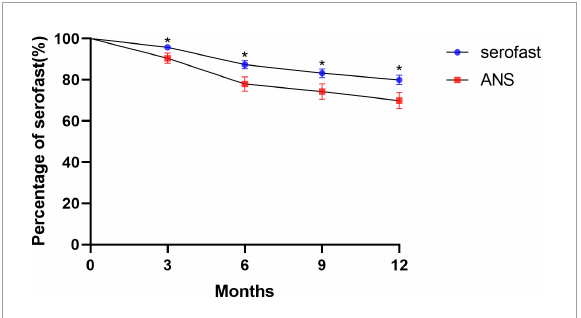
FIGURE1 Kaplan–Meier plots of the number of patients remaining in serofast status in the ANS group after therapy as compared with the serofast control group (* P < 0.05).